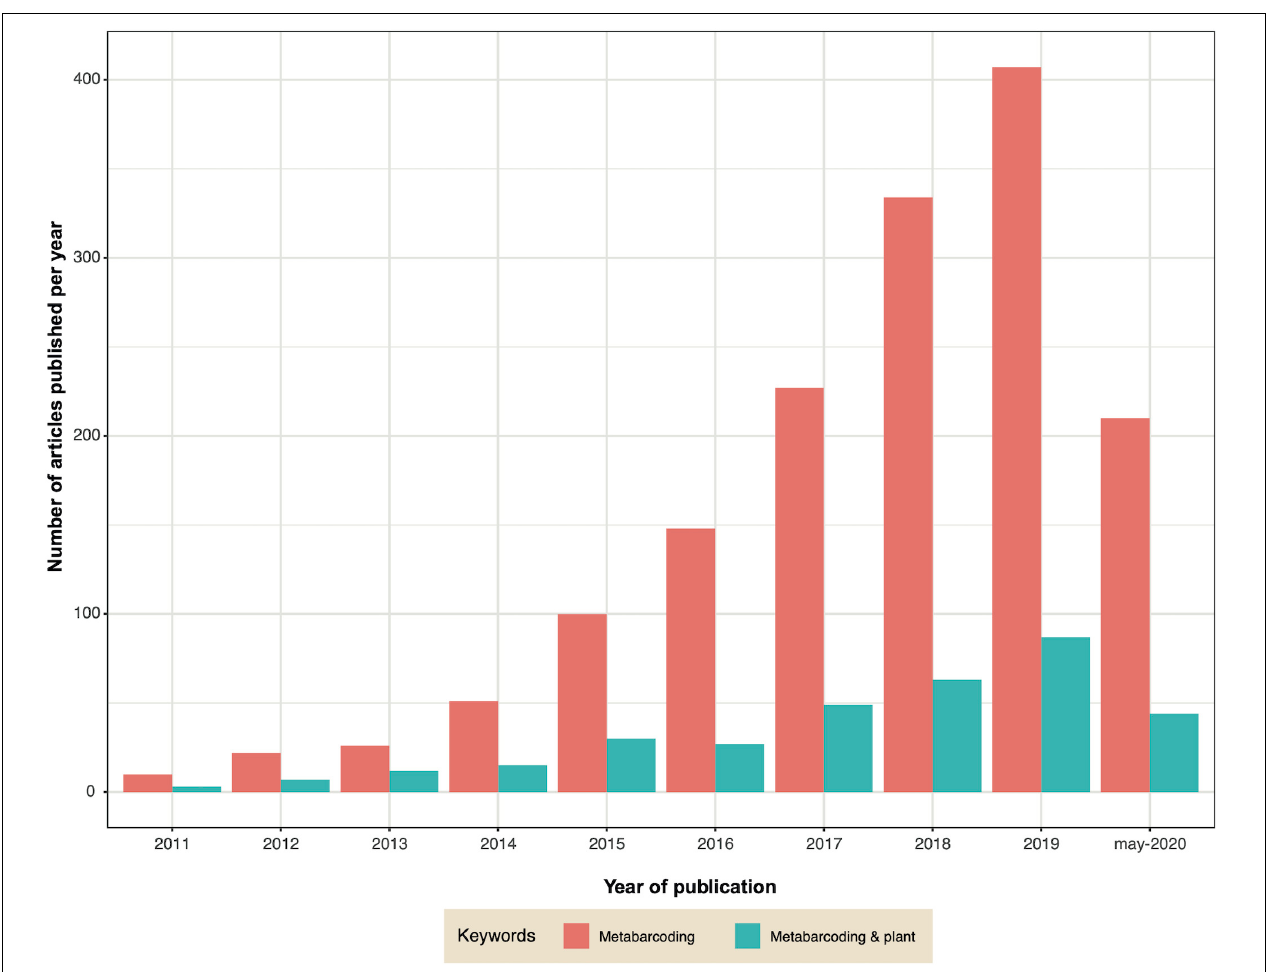
FIGURE 4 | Graph indicating the number of publications containing the keywords ‘metabarcoding’ (pink) or ‘metabarcoding AND plant’ (green) published each year since